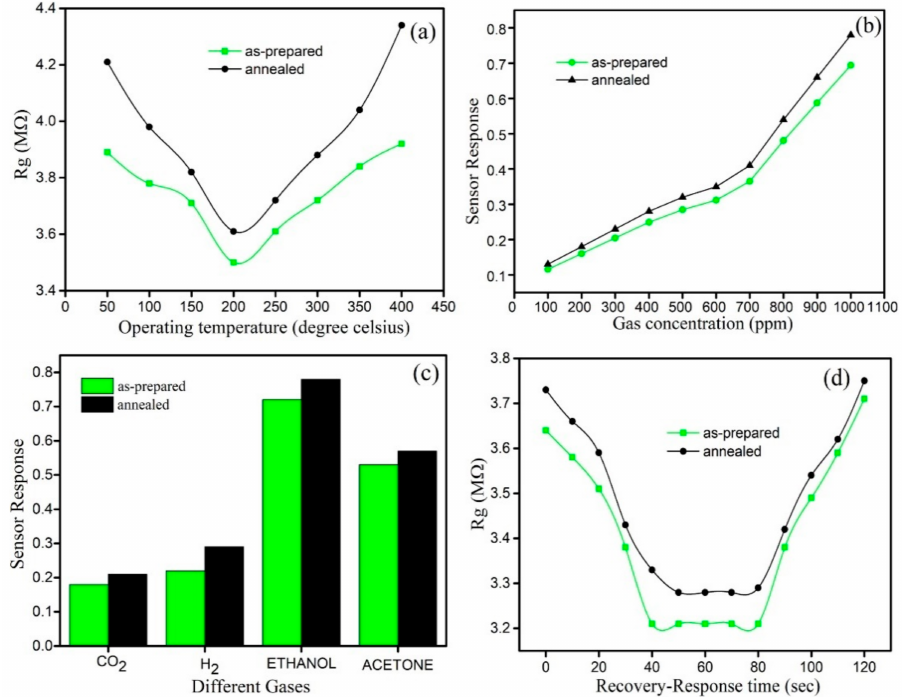
Figure 20. Gas sensor performance for synthesized (Fe 3 O 4 NPs), ( a ) The effect of temperature on the sensor resistance of the as-prepared and annealed samples ; ( b ) the sensor response towards various ethanol concentrations at 200 ◦ C; ( c ) the sensor response of the samples under 1000 ppm of different gases; ( d ) the response and recovery time of samples to 1000 ppm of ethanol at 250 ◦ C. Reprinted from Ref. [193] with permission of Elsevier Ltd.,